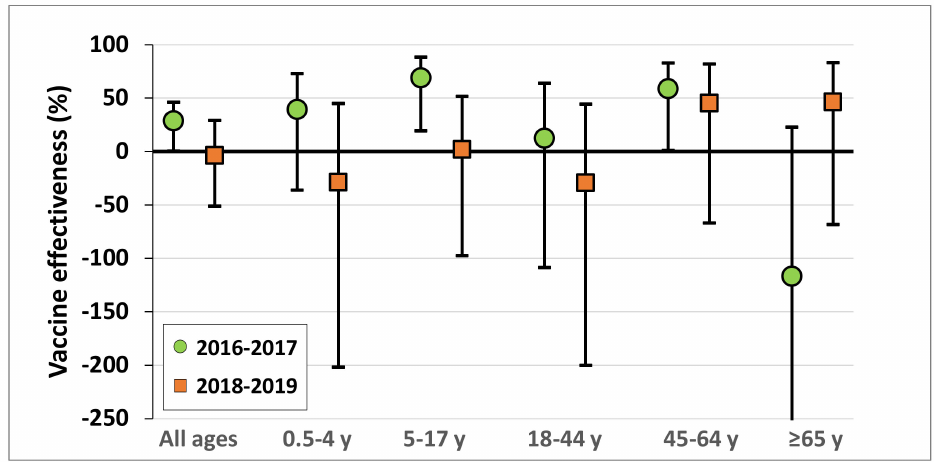
Figure 5. Adjusted influenza A (H3N2) VE of the 2018-2019 and the 2016–2017 influenza seasons for all ages and by age